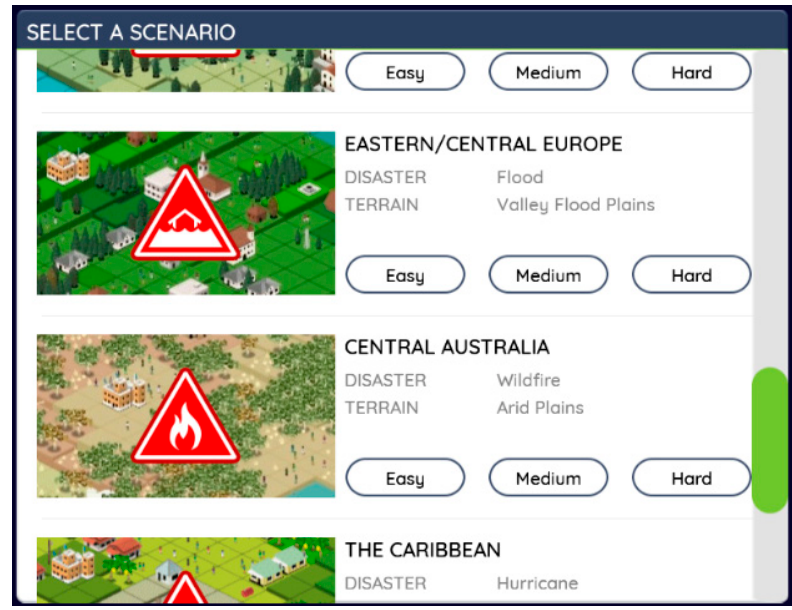
Figure 3. Use of Central Australia as a case for the bushfire gaming scenario.